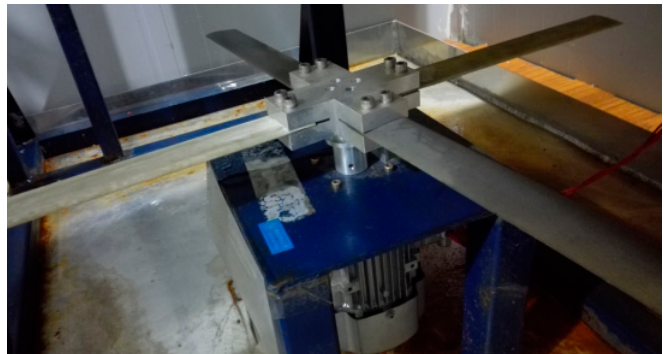
Figure 14. Blade distribution of different materials.